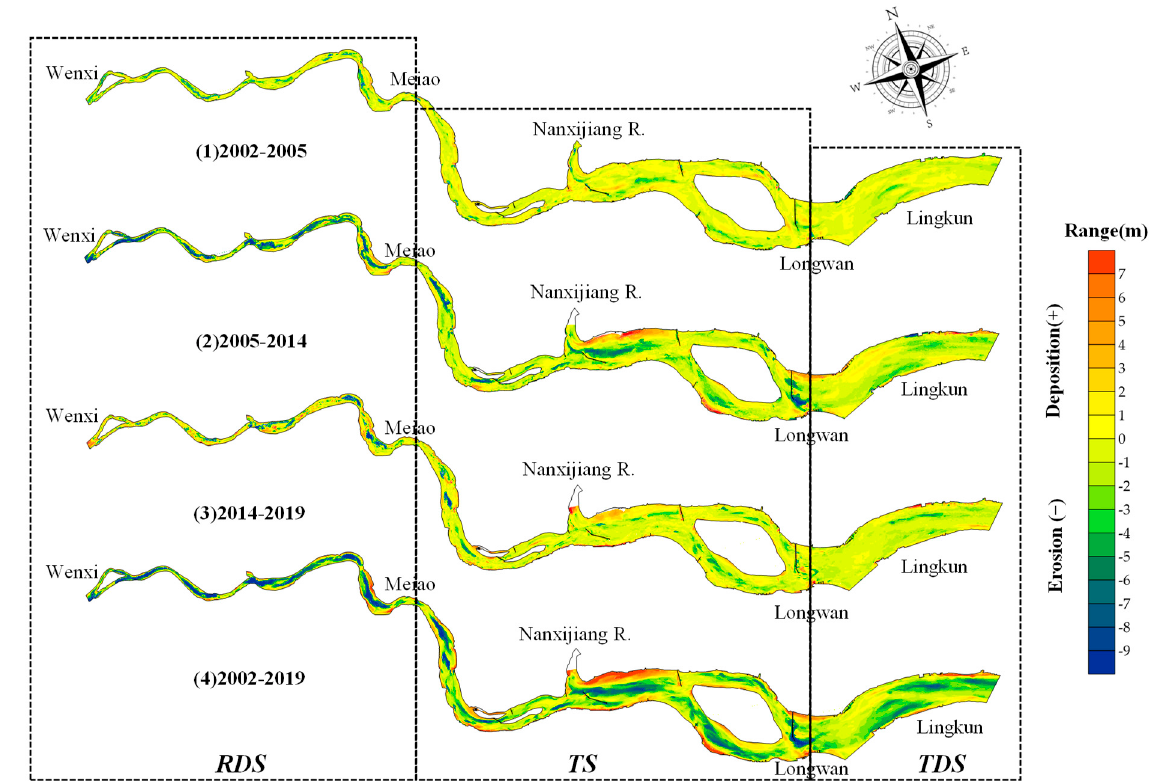
Figure 5. Interannual erosion and deposition changes of Oujiang Estuary in recent 20 years.